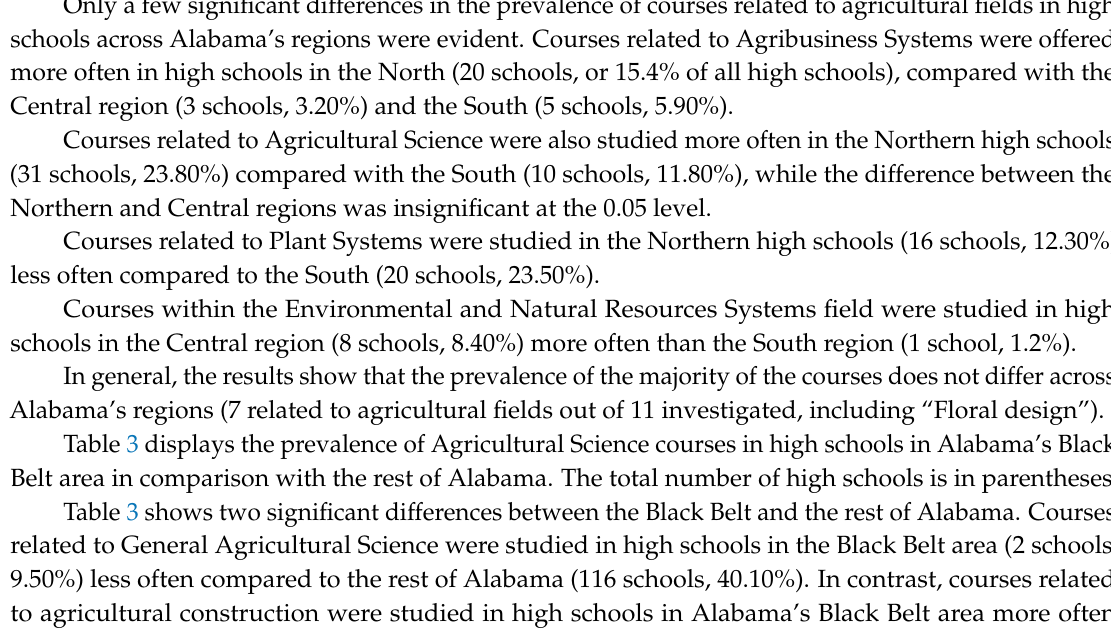
Agriculture-Related